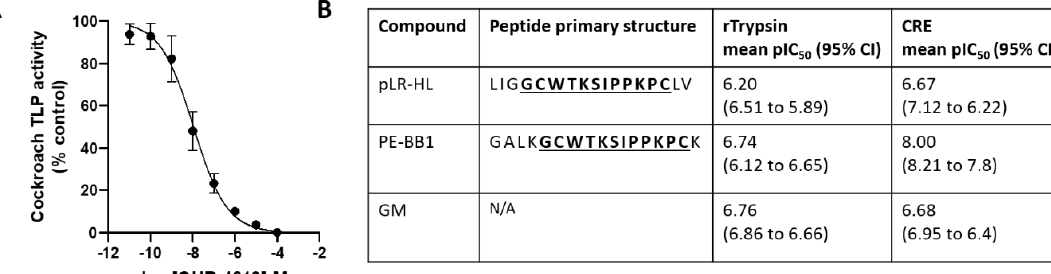
Figure 1. ( A ) Exemplar concentration – response (inhibition) curve analysis where the x-axis is the log QUB-1813 concentration (molar) and the y-axis the response (expressed as percentage inhibition calculated against the vehicle control value) for cockroach extract (CRE) trypsin-like protease (TLP) activity. ( B ) Summary table detailing the potency of candidate protease inhibitors tested against recombinant trypsin activity and the TLP activity present in CRE as assessed by fluorogenic peptide substrate-based assay. n ≥ 4.